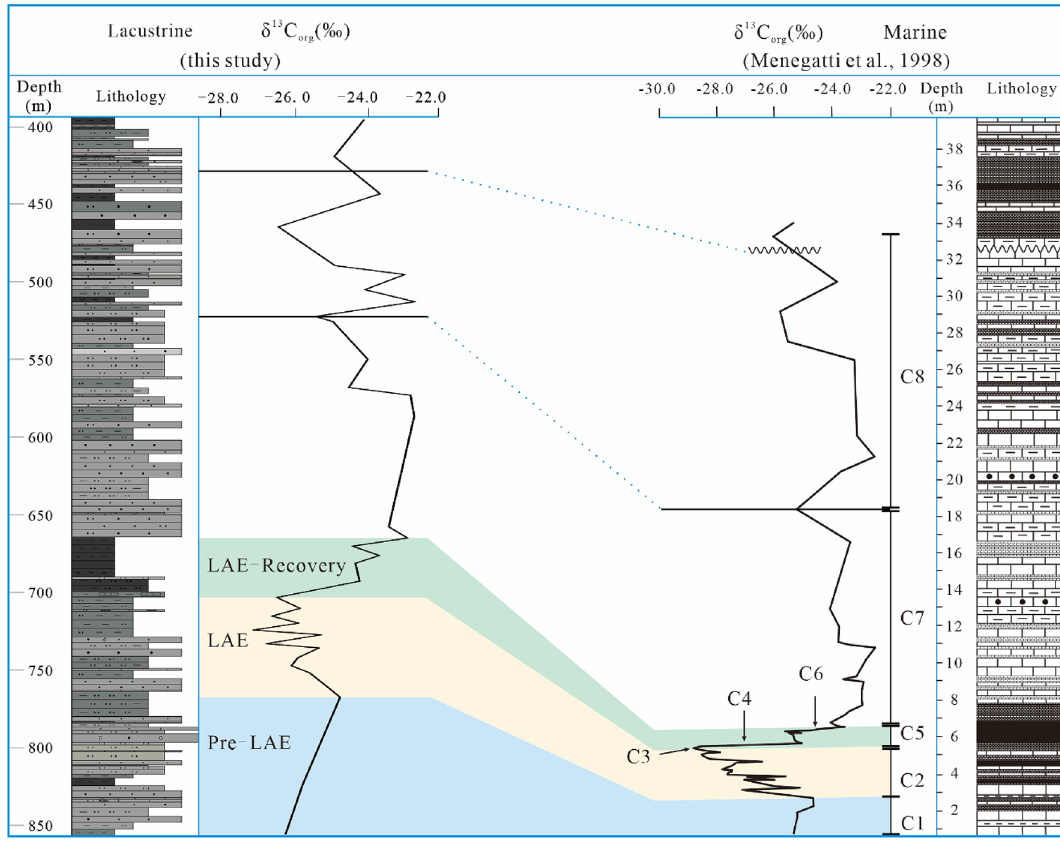
Figure 8. Correlation of the δ 13 C org curve for the continental Xiahuapidainzi Formation (LAE) with marine strata (OAE) from Italy 2